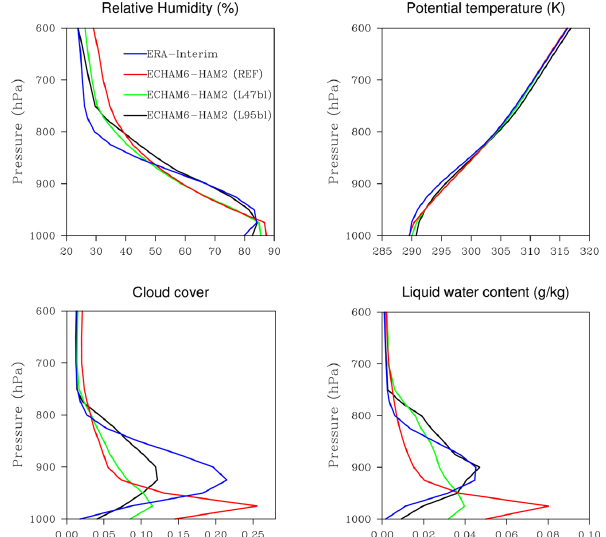
Figure 13. Vertical profiles of relative humidity, potential tempera- ture, cloud cover and liquid water content in stratocumulus regions (in-regime values). The green line is for a simulation with the L47bl vertical grid, the black line for L95bl, the red line for the ECHAM6- HAM2 reference simulation and the blue line for ERA-Interim